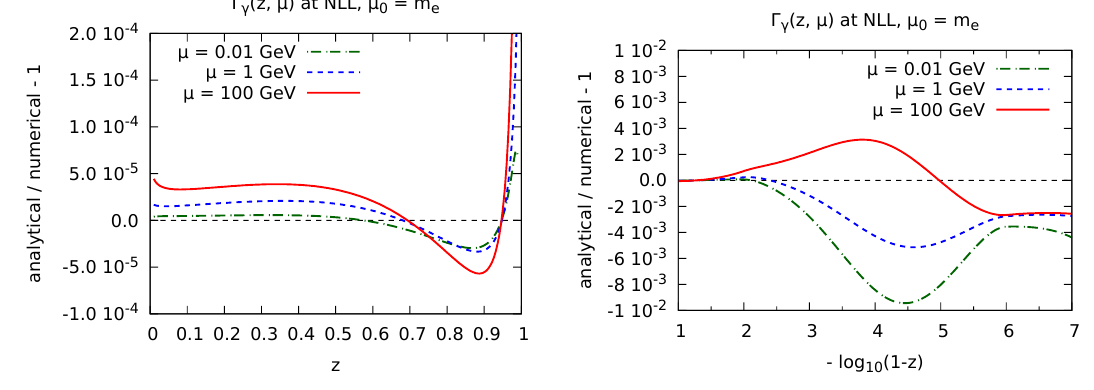
Figure 8 . As in (cid:12)gure 6, for the